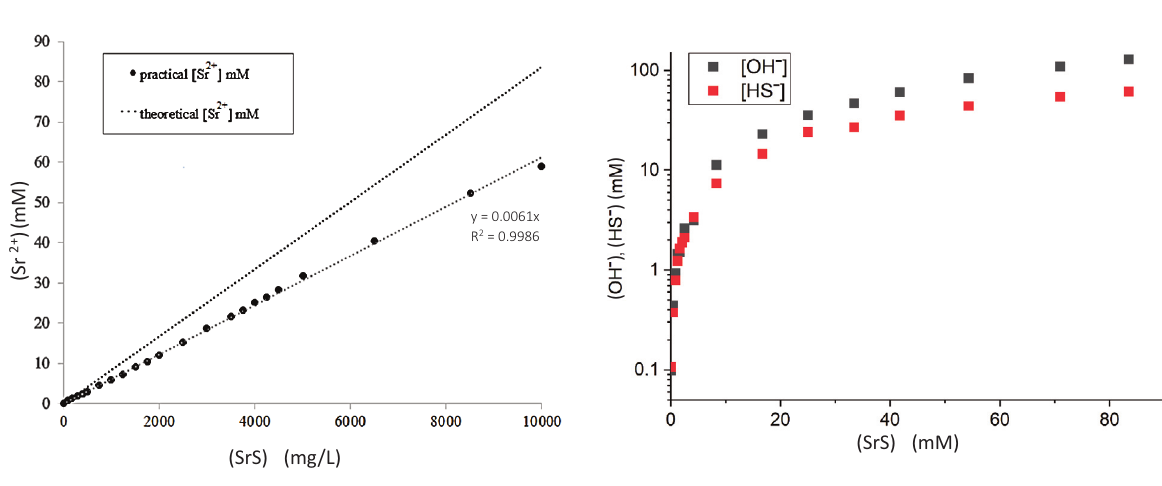
Fig. 4. Correlation between the experimentally measured [HS − ] and [OH − ] ions in the [SrS] range of 15−10 540 mg·L - 1 (0.125– 83.552 mM) in logarithmic scale.